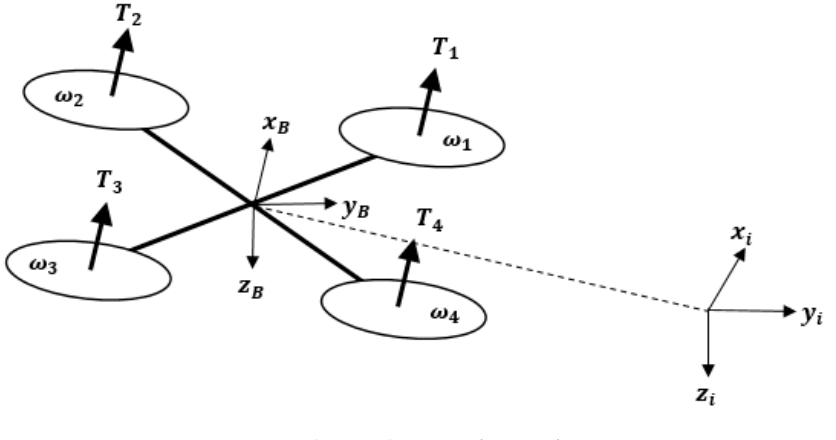
Figure 1. The quad-rotor reference frames.